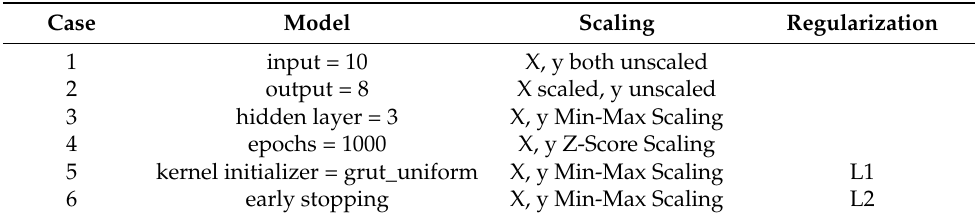
Table 1. Model Configuration of Six Cases.